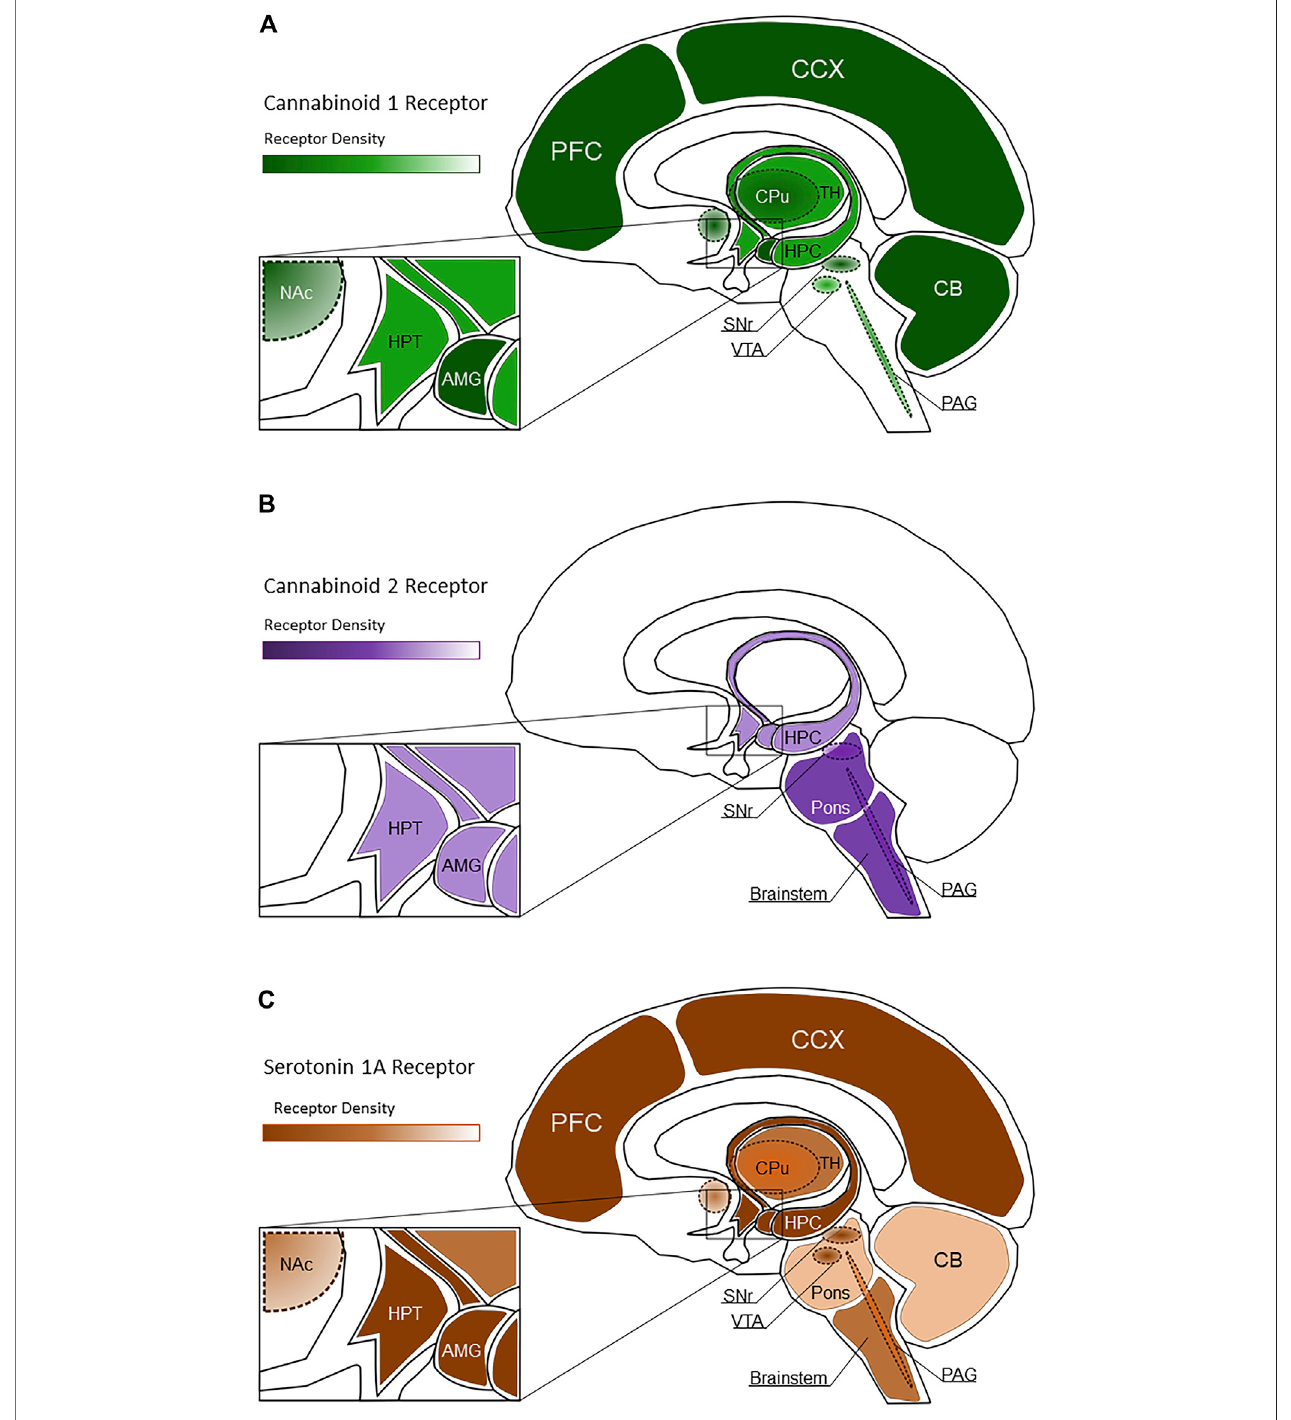
FIGURE 1 | Spatial distribution of CB 1 R [ (A) , green shading], CB 2 R [ (B) , purple shading], and 5-HT1A receptors [ (C) , brown shading] within healthy brain regions. Lighter shaded regions represent low receptor density while darker shaded regions represent high receptor density. In these images, PFC, Prefrontal Cortex; CCX, Cerebral Cortex; CB, Cerebellum; CPu, CaudatePutamen; HPC, Hippocampus; TH, Thalamus; HPT, Hypothalamus; Nac, NucleusAccumbens; SNr, Substantia Nigra pars compacta; VTA, Ventral Tegmental Area; PAG, Periaqueductal gray; AMG, Amygdala.